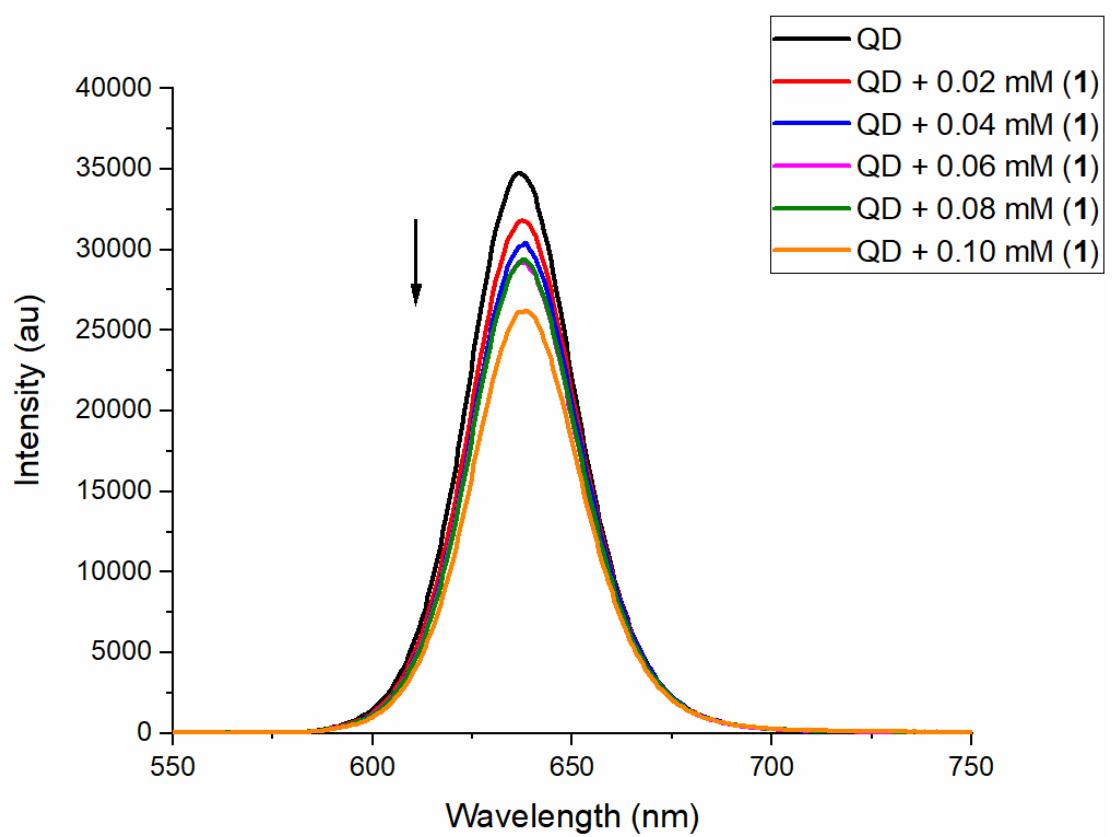
Figure 4. Emission spectra of MPA-CdTe quantum dots (1.4 × 10 − 6 M, 0.5 mg/mL) with increasing concentration of 1 (0 to 0.10 × 10 − 3 M) in water (excitation wavelength: 514 nm).